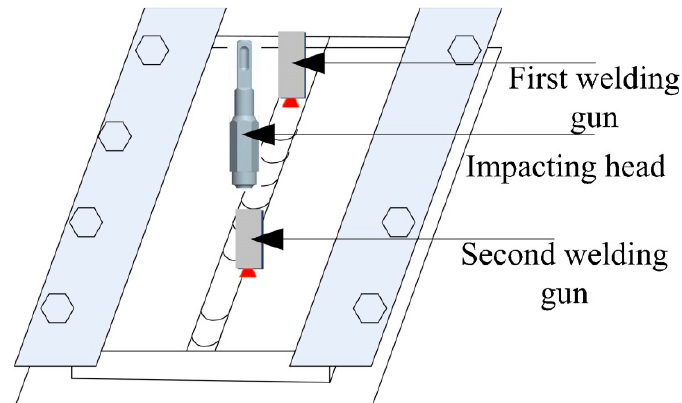
Figure 1. Scheme of the welding process using the two-pass impacting Trailed welding (ITW) method [23].